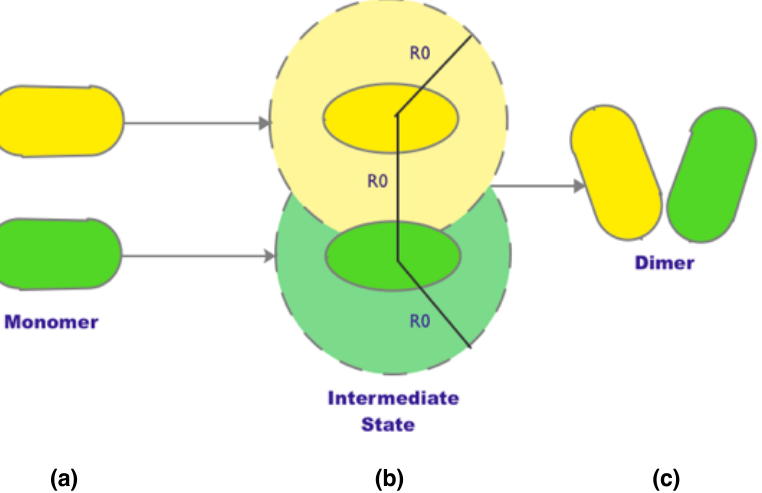
Figure 3. Association pathways of SARS-CoV M Pro -C. ( a ) Two monomers colored separately in yellow and green. ( b ) When the interparticle distance between two monomers is smaller than R 0 , then two monomers will interact with each other, forming an monomeric-like intermediate state. ( c ) The intermediate has a high reaction propensity, easily forming dimers with other intermedi- ate state within reaction radius R 0 . This hypothetical reaction model was inferred from research papers